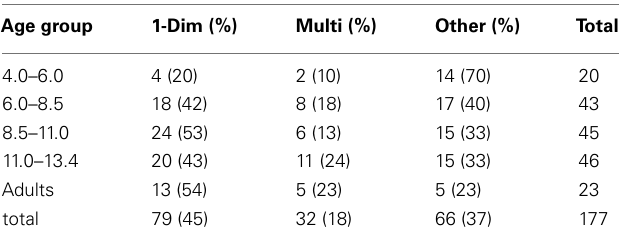
Table 4 | Number of participants using different strategies by age